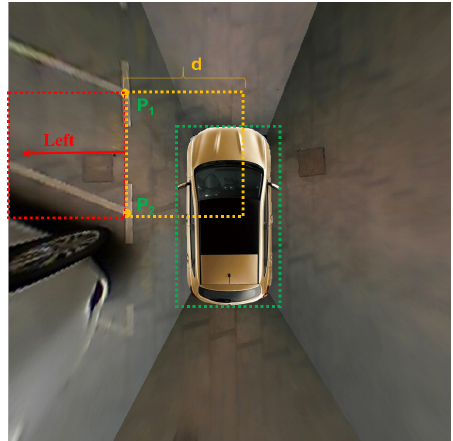
Figure 7. The orientation of the parking slot when the vehicle is around it. Two rectangular boxes formed by the entrance line with a depth d are marked with red and orange dotted lines. The rectangular box formed by the car model is marked with gree dotted lines. The red arrow indicates the orientation of the parking slot.